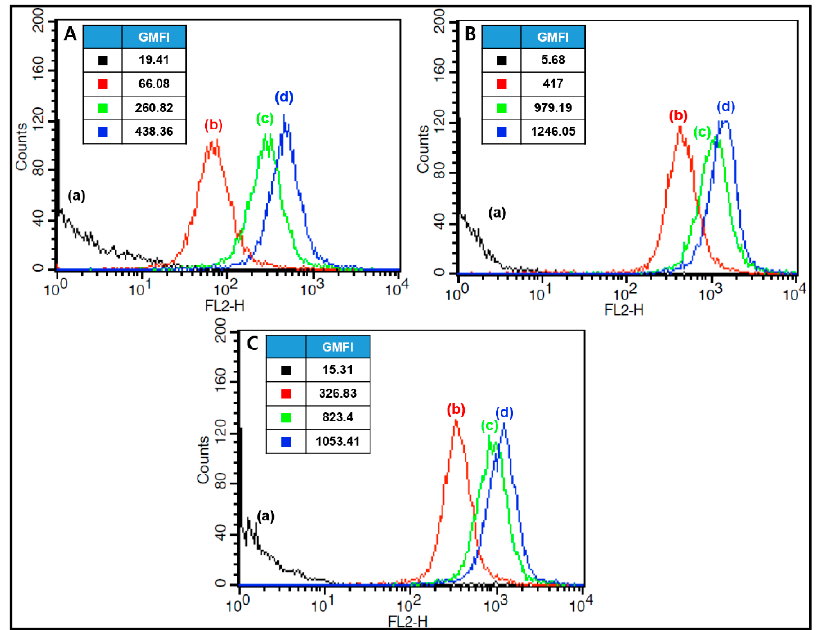
Figure 10. Flow cytometric profile of KB cells treated with free DOX ( A ), P(HEA- co -PVS)(97 / 3) / DOX micelles ( B ), and P(HEA- co -ABZ) / DOX micelles ( C ) after the treated cells were incubated for 0 ( a ), 0.5 ( b ), 2 ( c ) and 4 h ( d ).